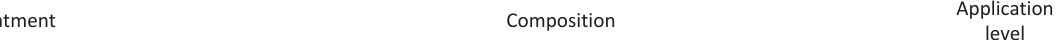
Table 1. Additive treatments used in the ensling experiment Treatment Composition